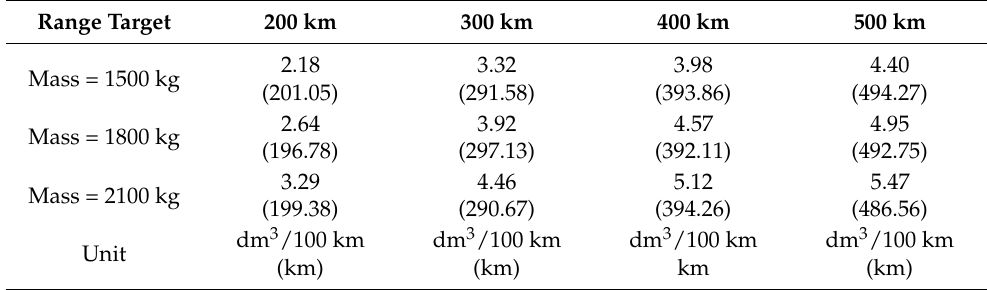
Table A8. Fuel consumption in EREV mode for CLTC-P Phase 3.